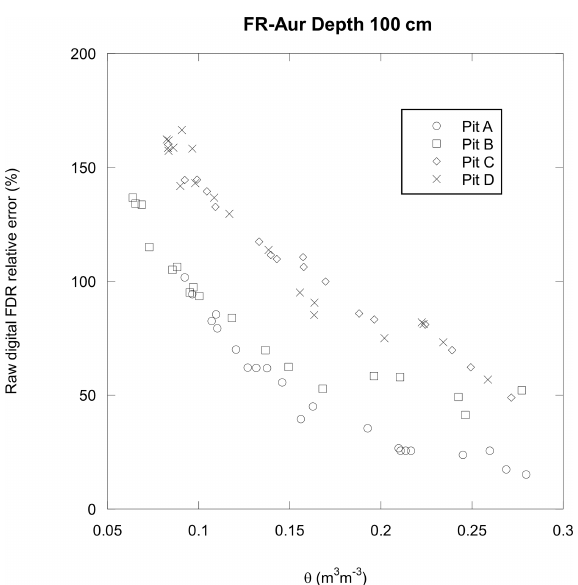
Figure 8. SWC provided by digital FDR recalibrated sensor using soil-specific calibration coefficients for the same pit and depths as in Fig.